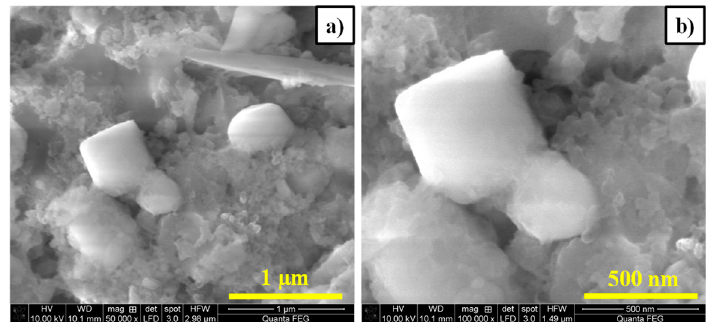
Figure 7. ( a , b ) SEM image of Li 2 FeSiO 4 /C after the 100th cycle (post-mortem).